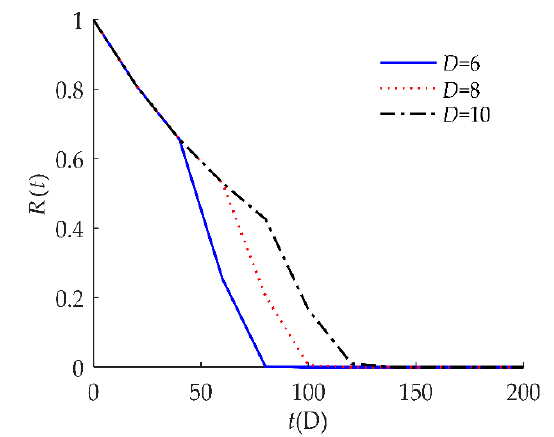
Figure 10. Sensitivity analysis of R ( t ) on τ for example II.